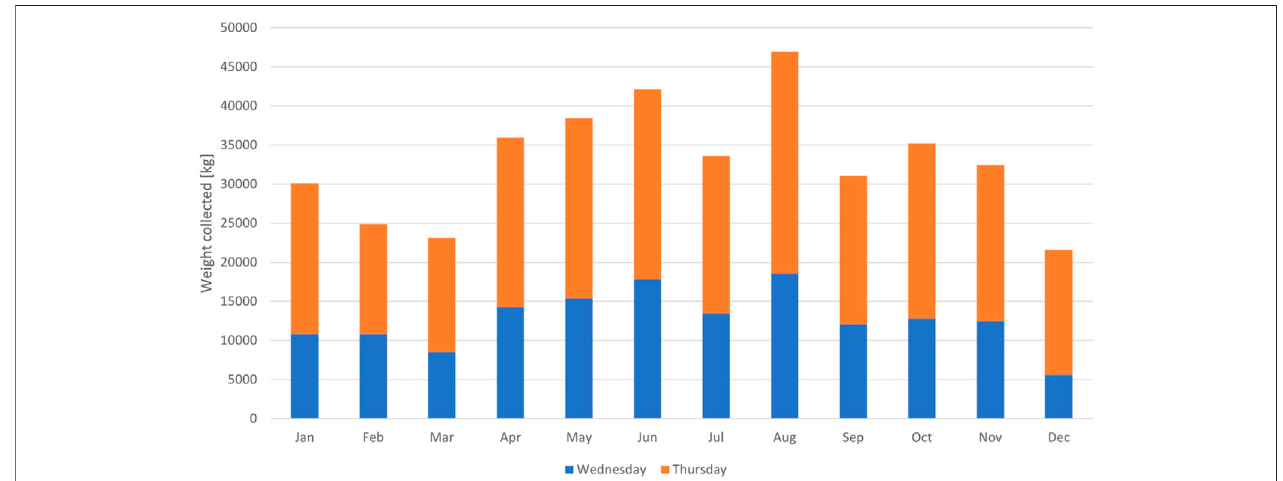
FIGURE 13 | Monthly collection of kitchen and garden waste in the case study region: De Pinte, Flanders, Belgium.